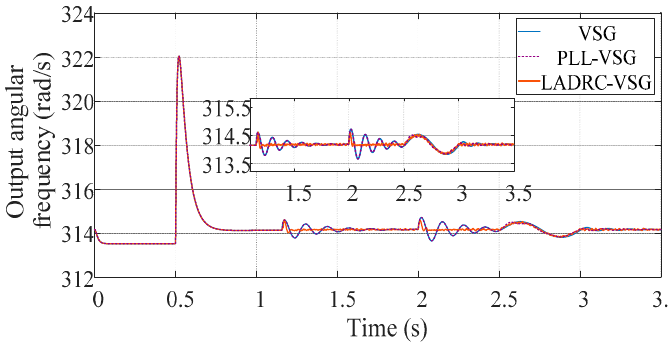
Figure 24. Corresponding output reactive power of VSG under different control strategies.